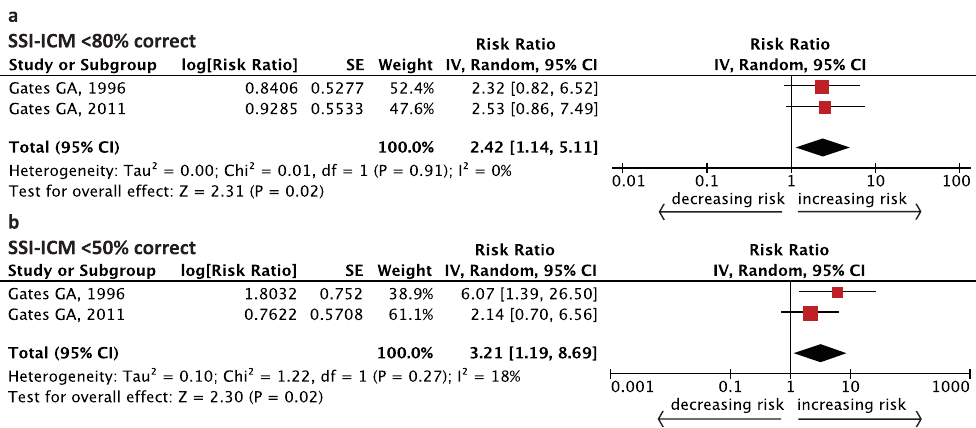
Figure 3. Forest plot showing the risk of incident cognitive impairment from one central auditory processing test. Combined relative risk from ( a ) moderate impaired central auditory processing (SSI-ICM < 80% correct) and ( b ) severe impaired central auditory processing (SSI-ICM < 50% correct). CI = confidence interval, IV = inverse variance, SE = standard error, SSI-ICM = Synthetic Sentence Identification with Ipsilateral Competing